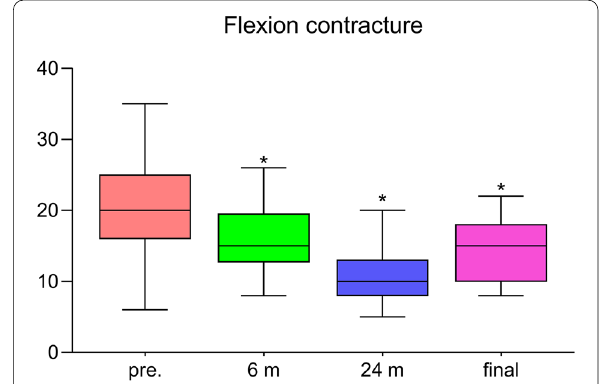
Fig. 1 Trend in the flexion contracture, with the results obtained preoperatively, at 6 and 24 months postoperatively, and at the final follow-up shown. Pre . preoperative; * P value < 0.05 versus the